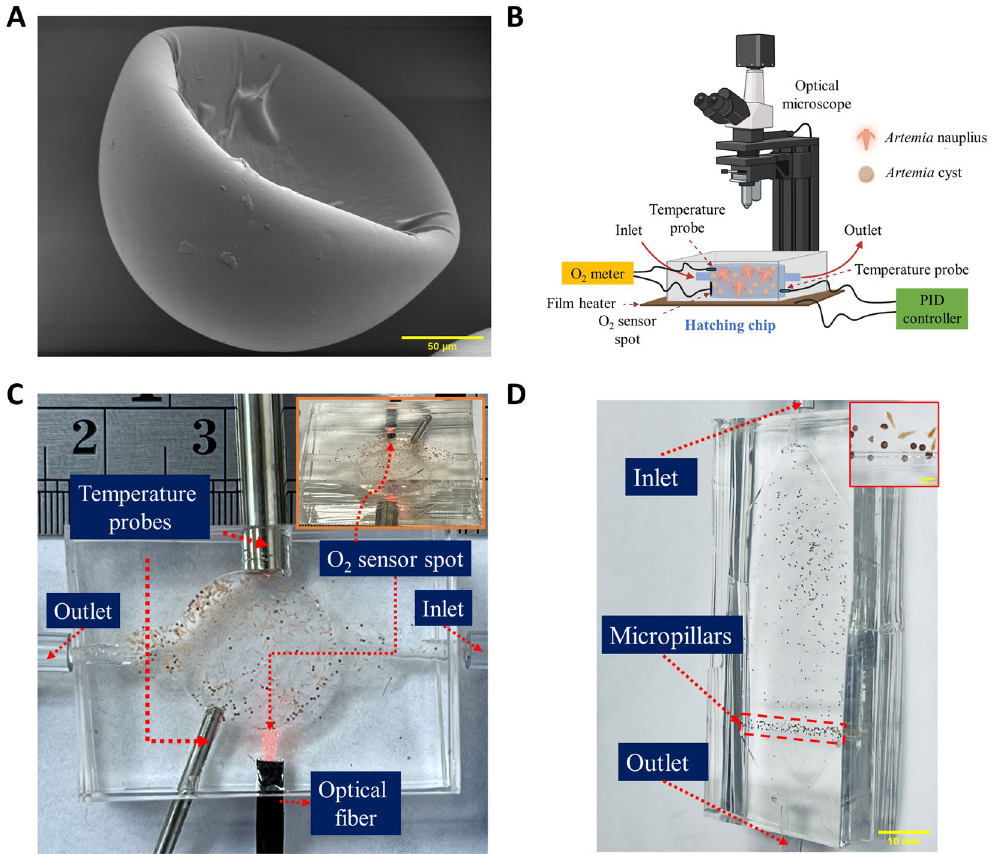
Figure 1. Experimental setup. ( A ) Scanning electron microscopy (SEM) shows the cup-like structure of the as-received Artemia cysts at 450X magnification. ( B ) Schematic overview of the microfluidic platform to study the effect of abiotic environmental parameters on the hatching performance of Artemia . ( C ) Hatching chip with integrated O 2 sensor and temperature probes connected (scale bar = 5 mm) (Position of O 2 sensor spot is shown in inset) ( D ) Counting chip with sieving-like structures made of PDMS micropillars at the outlet (scale bar = 10 mm) [Cysts and nauplii entrapped at the sieving structures are shown in inset (scale bar = 500